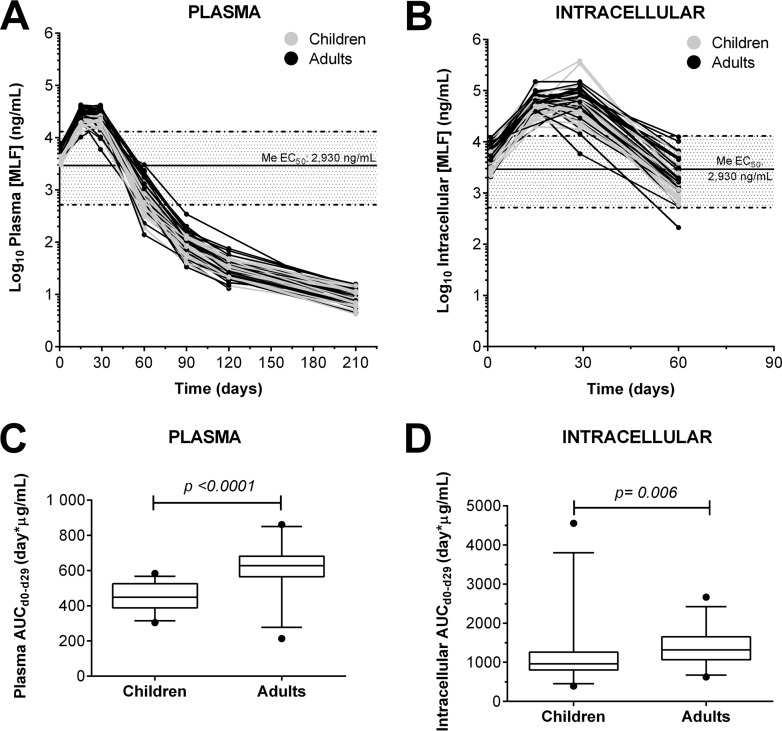
Concentration-time curves of miltefosine in plasma and PBMC samples. (A and B) Miltefosine concentrations measured in plasma (A) and PBMCs (intracellular) (B) from samples obtained from children (n = 30) and adults (n = 30) throughout the course of treatment and up to 6 months of follow-up. (C and D) Plasma (C) and intracellular (D) areas under the concentration-time curve. Box plots show median values and 5th to 95th percentiles. Solid lines represent the median EC50 and dashed lines represent the minimum and maximum EC50 reported for Leishmania (Viannia) clinical strains from a similar patient cohort (19).